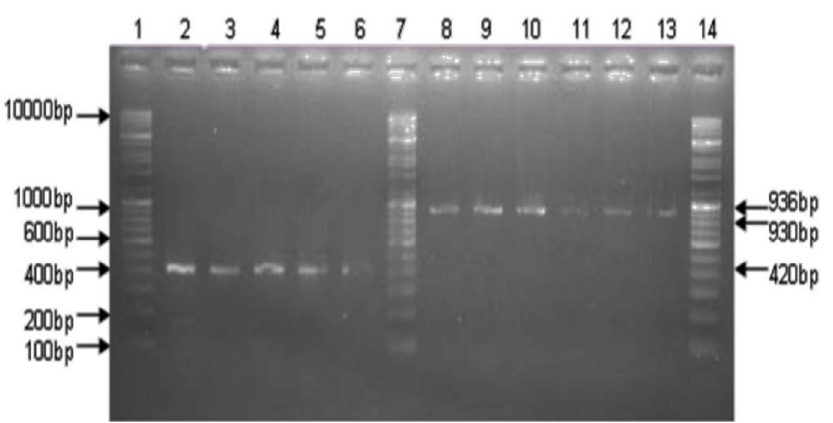
Fig. 2. 2 % Agarose gel is showing positive isolates of CTX-M-group-1 type gene (Lane 2-6) of 420 bp, positive isolates of SHV (lane 8-10) of 930 bp, positive isolates of TEM (lane 11-13) of 936bp, lanes 1,7,14 are showing Genei high range DNA